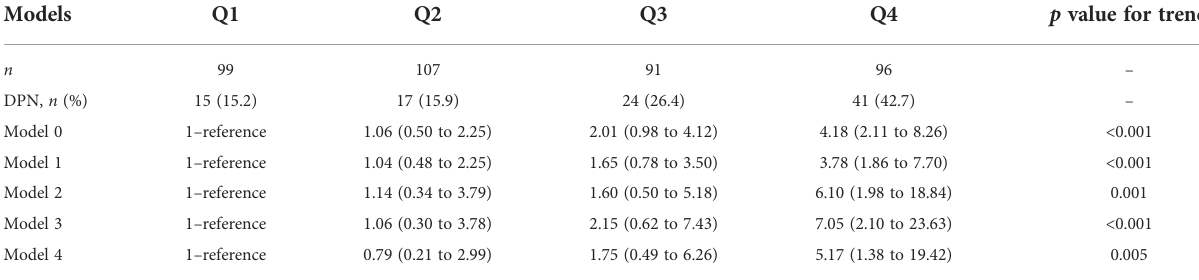
TABLE 3 Risks for DPN at differential levels of plasma D-dimer quartiles (ORs [95% CIs]).